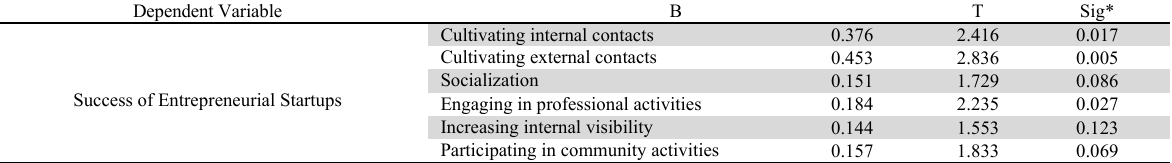
Multiple Regression Analysis to Ensure the Impact of Networking Behaviors Dimensions on the Success of Entrepreneurial